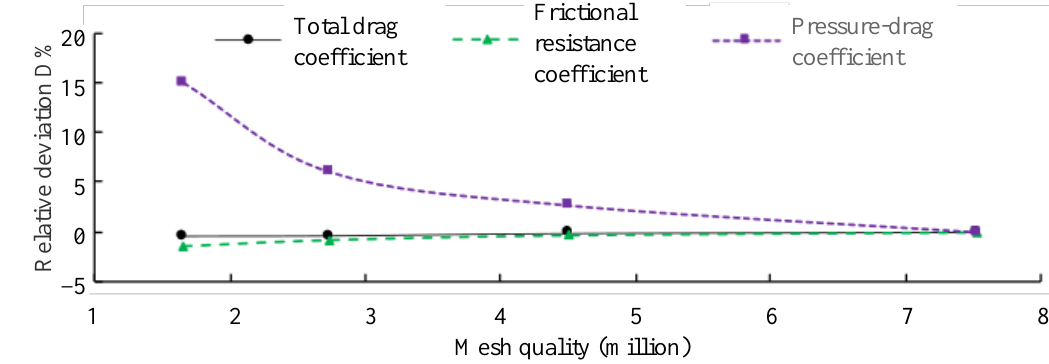
Figure 4. Verification results of mesh independence.